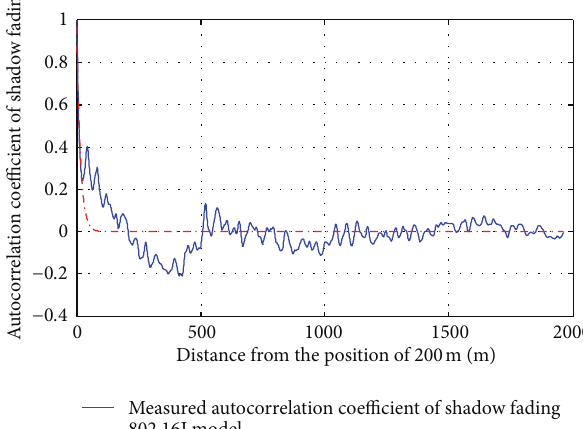
Figure 6: Autocorrelation coefficient of shadow fading in hilly terrain.